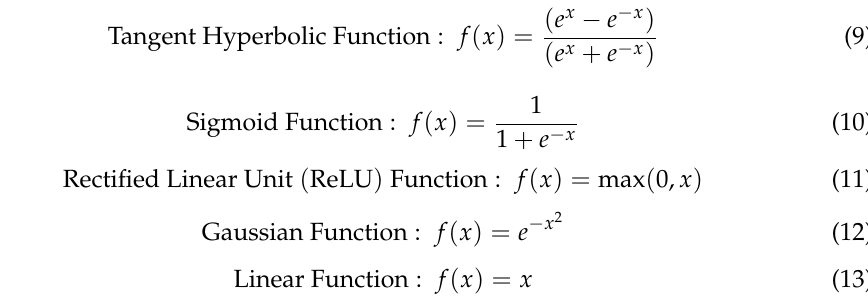
Figure 13. Error histogram of the proposed ANN architecture for RSSI prediction for the training, validation and testing phases. Figure 14. Regression Fits for the proposed ANN architecture for RSSI prediction.